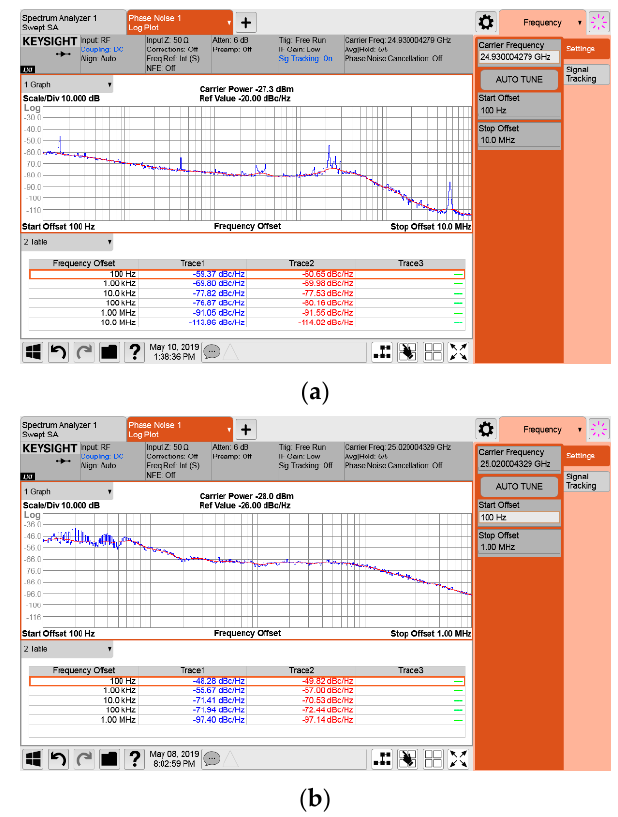
Figure 12. The die photograph of the PLL.